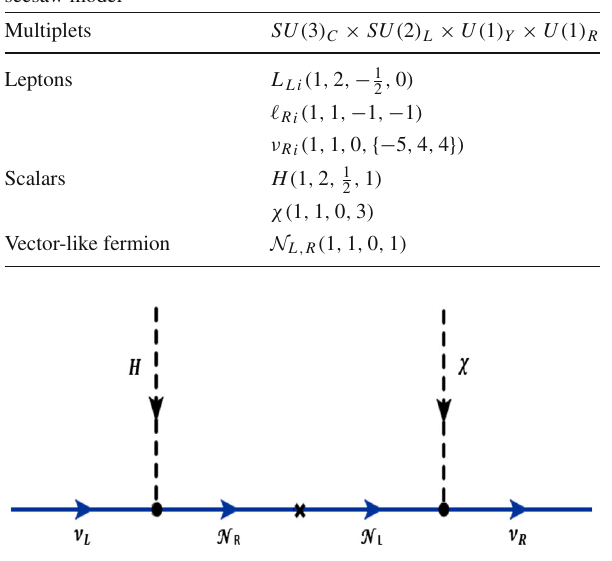
Fig. 1 Representative Feynman diagram for tree-level Dirac Seesaw